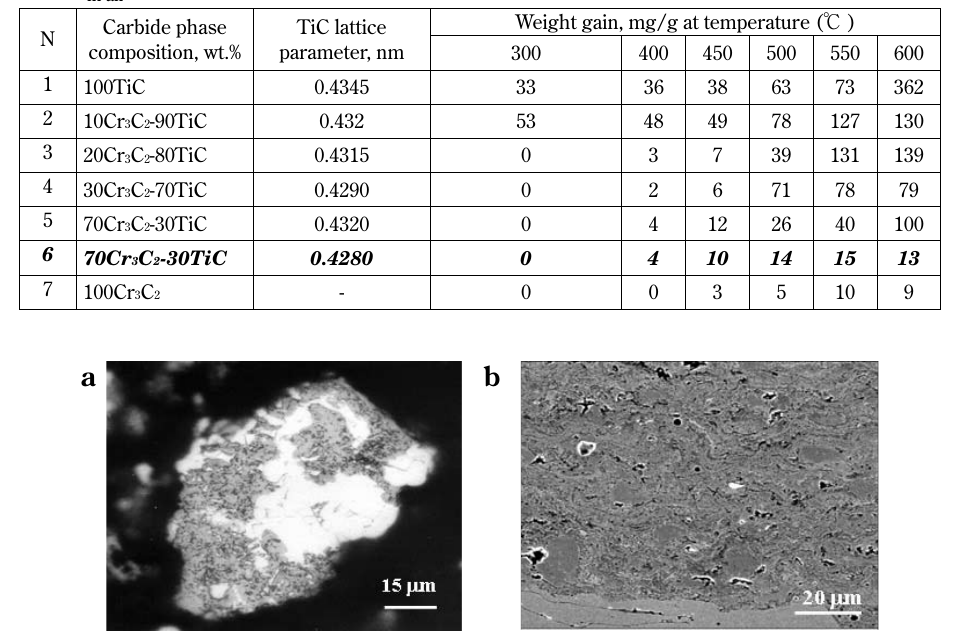
Fig.10 Cross-sections of (Cr 3 C 2 -TiC) / NiCr powder (a) and HVOF coating from it (b).